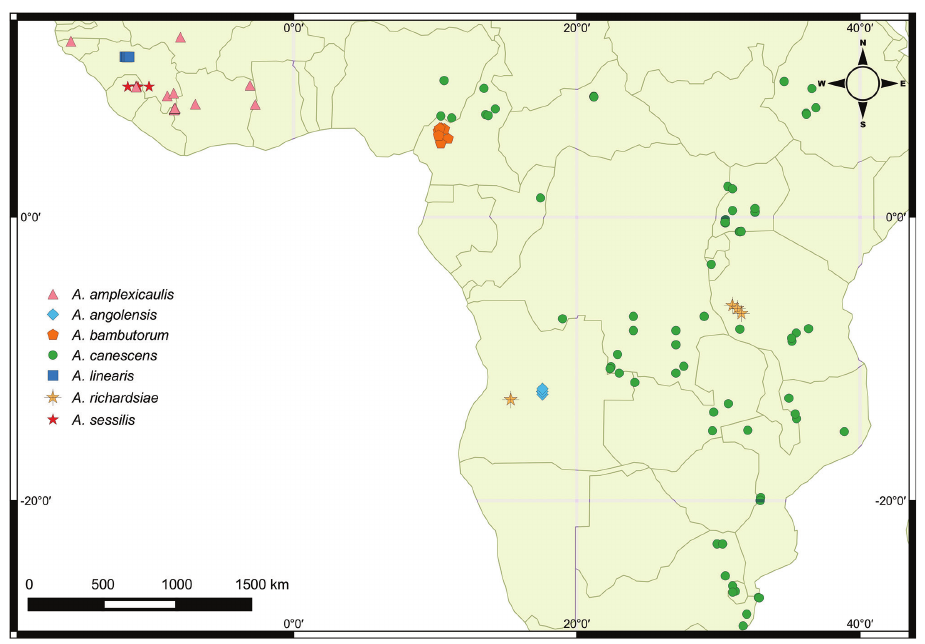
Figure 2. Distribution map of Argyrella